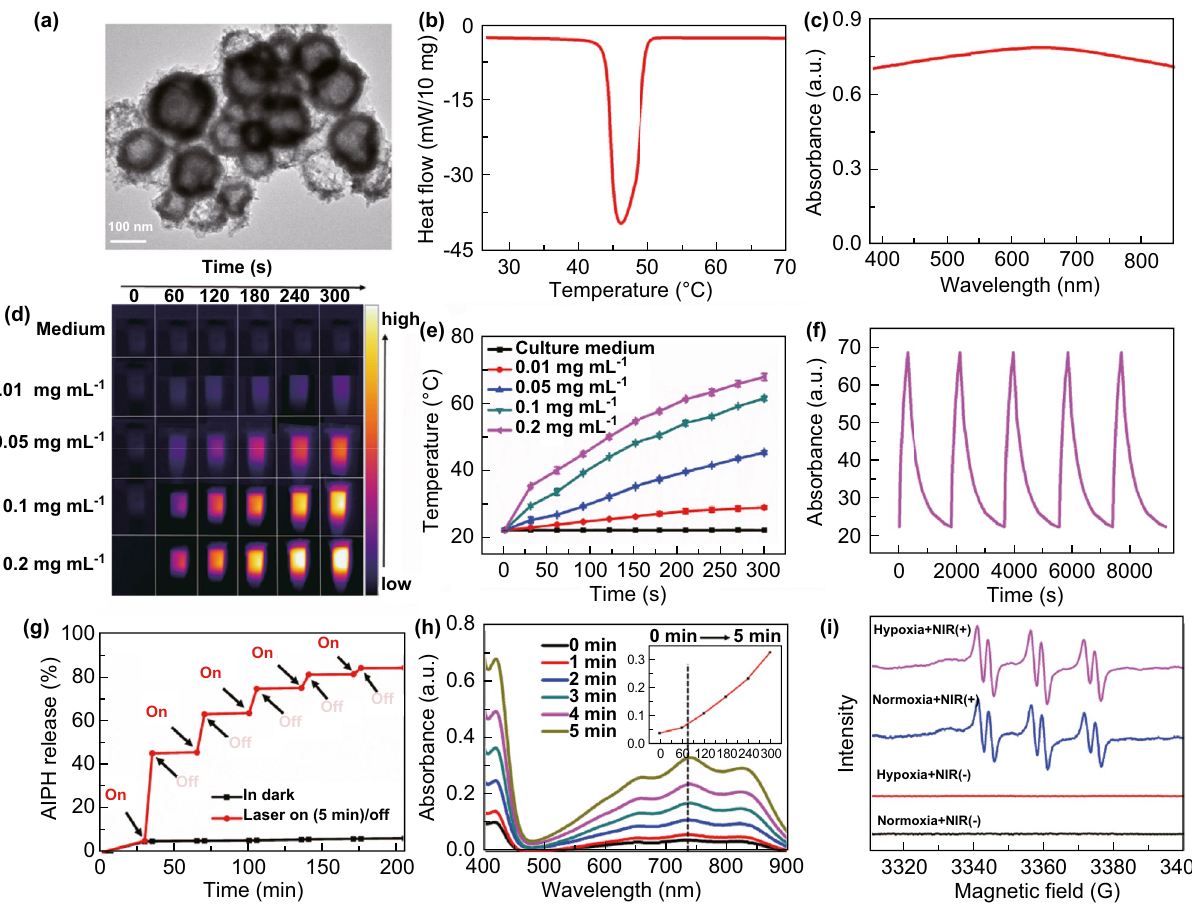
Fig. 1 Characterization of Bi 2 Se 3 @AIPH NPs and measurements of photothermal and free radical properties. a TEM images, b DSC curve, and c UV–Vis spectrum of Bi 2 Se 3 @AIPH. d Representative photothermal images of Bi 2 Se 3 @AIPH solution at the concentrations of 0, 0.01, 0.05, 0.1, and 0.2 mg mL −1 (1 W cm −2 , 5 min). e Corresponding temperature change evaluation at various concentrations. n = 3 f Cycle stability of Bi 2 Se 3 @AIPH (0.2 mg mL −1 Bi 2 Se 3 @AIPH solution as the representative). g . Thermo-responsive release profiles of AIPH from Bi 2 Se 3 @AIPH NPs, and the ‘‘on’’ switch represents the NPs are irradiated for 5 min (1 W cm −2 ) by 808 nm laser, and the ‘‘off’’ means the irradiation stops. Except the irradiation, the NPs solution was placed in the environment of 37 °C. h Absorbance of ABTS +· generated from the reaction of ABTS and Bi 2 Se 3 @AIPH under 0–5 min irradiation (1 W cm −2 , 5 min). i electron spin resonance (ESR) spectrum of 50 mM POBN in 0.1 mg mL −1 Bi 2 Se 3 @AIPH with or without irradiation at normoxic and hypoxic